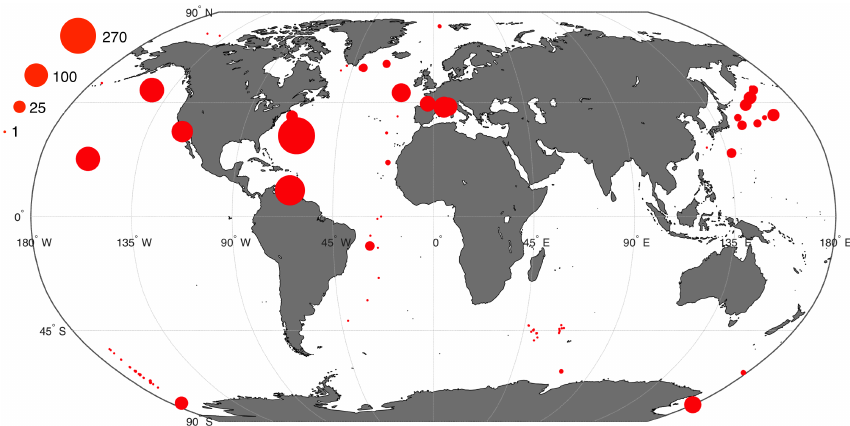
Figure 3. Spatial distribution of coincident satellite and POC flux observations. The size of the circle represents the number of coincident observations (see legend).